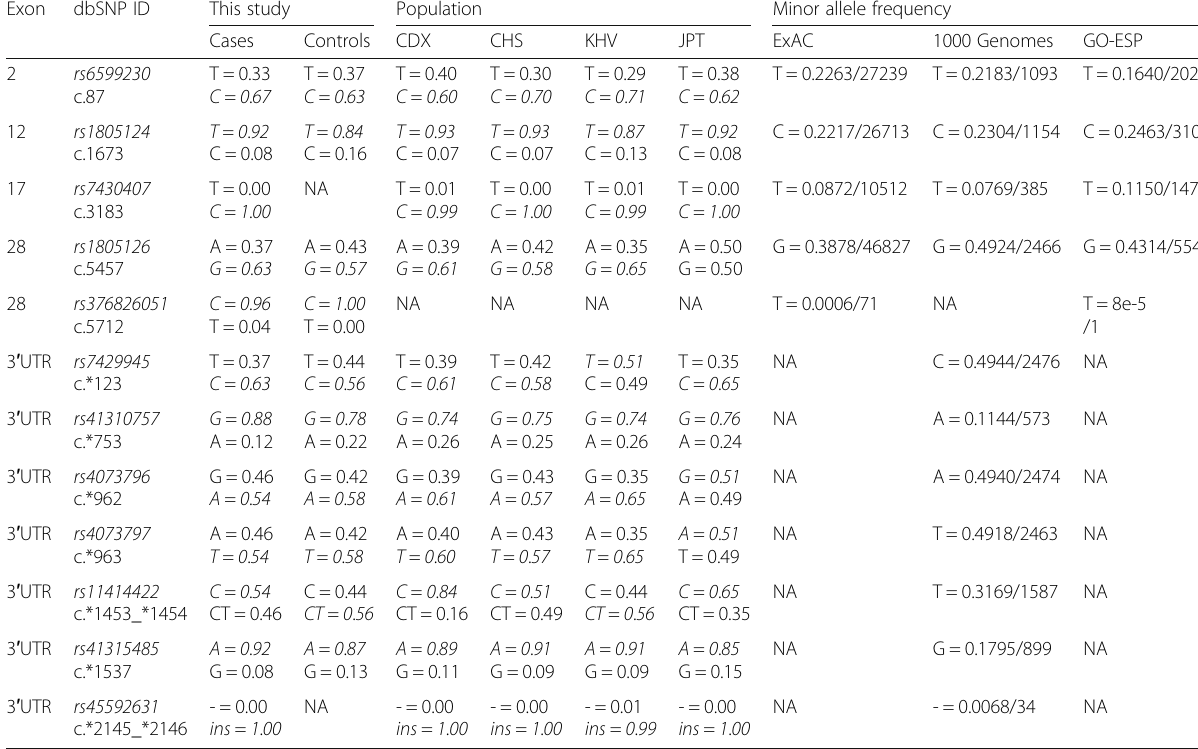
Table 2 Allele frequency of each variant identified in this study, using 151 control subjects compared with frequency from various